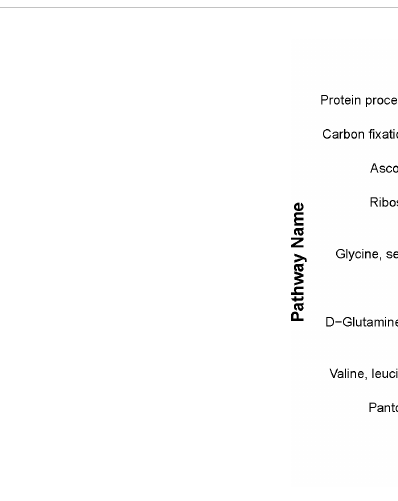
FIGURE 6 Top twenty KEGG pathways enrichment of